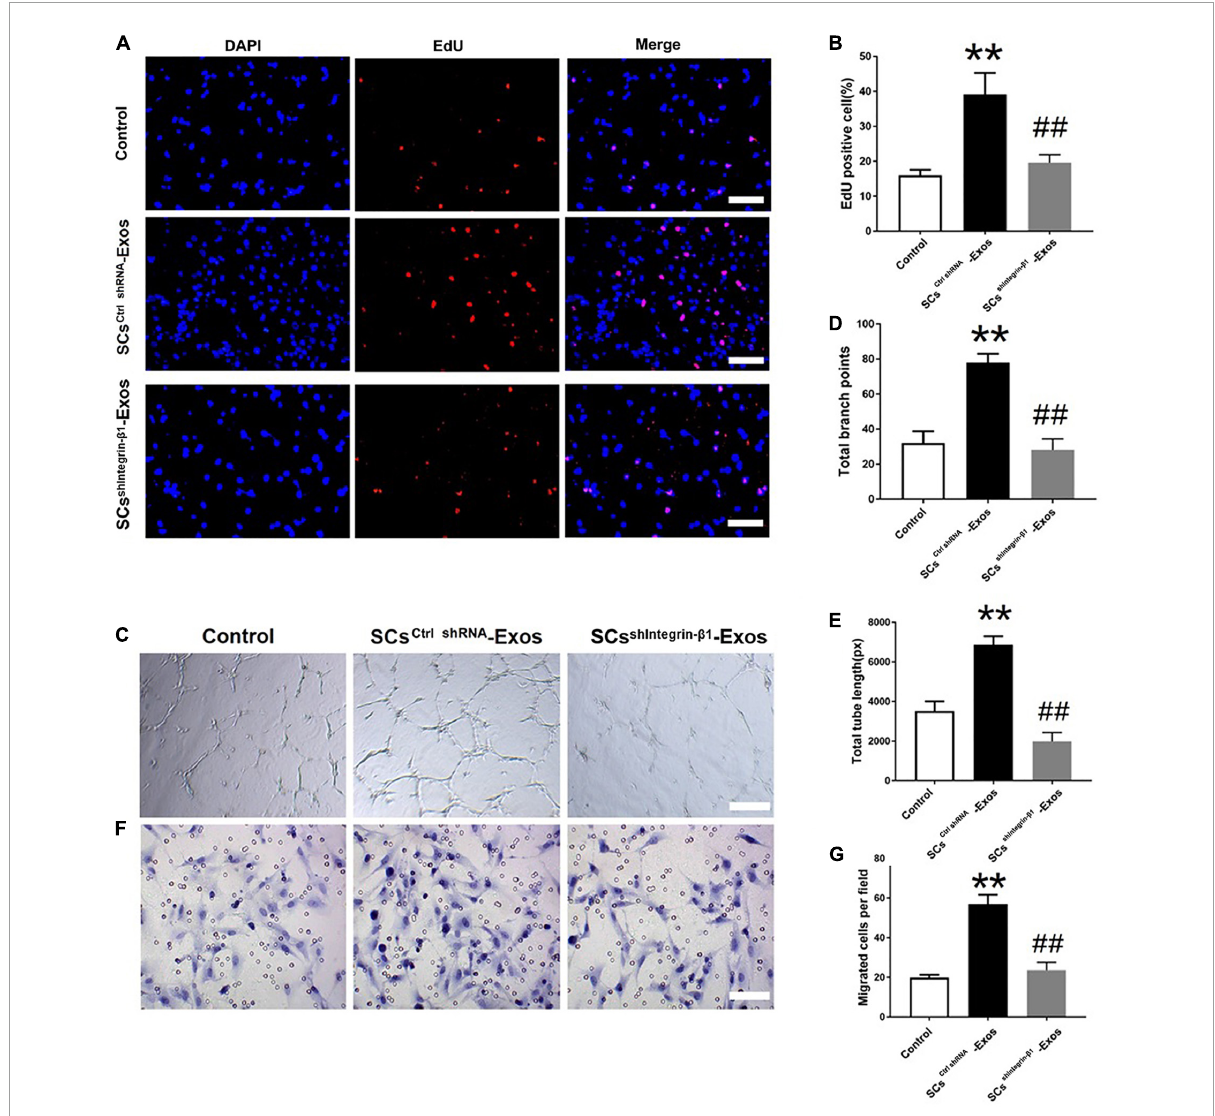
FIGURE4 Integrin- β 1 is required in mediating the role of SCs-Exos for promoting angiogenesis on Endothelial Cells. (A) The proliferation of bEnd.3 cells was performed by EdU test. (D) Quantitative analysis of EdU-positive cells in each group. (B,E,F) Tube formation and migration were measured by the capillary network formation assay and transwell chamber migration assay 6 h after seeding bEnd.3 cells pretreated with PBS, SCs ctrlshRNA -Exos, or SCs sh Integrin − β 1 -Exos. (C) Photomicrographs of tube-like structures and quantification of the tube number. Photomicrographs of bEnd.3 cells that migrated through the Transwell R (cid:13) membrane. The bEnd.3 cells were stained with crystal violet. (G) Quantification of the number of the migrated bEnd.3 cells. The data are presented as mean ± SD. ** p < 0.01 Control group